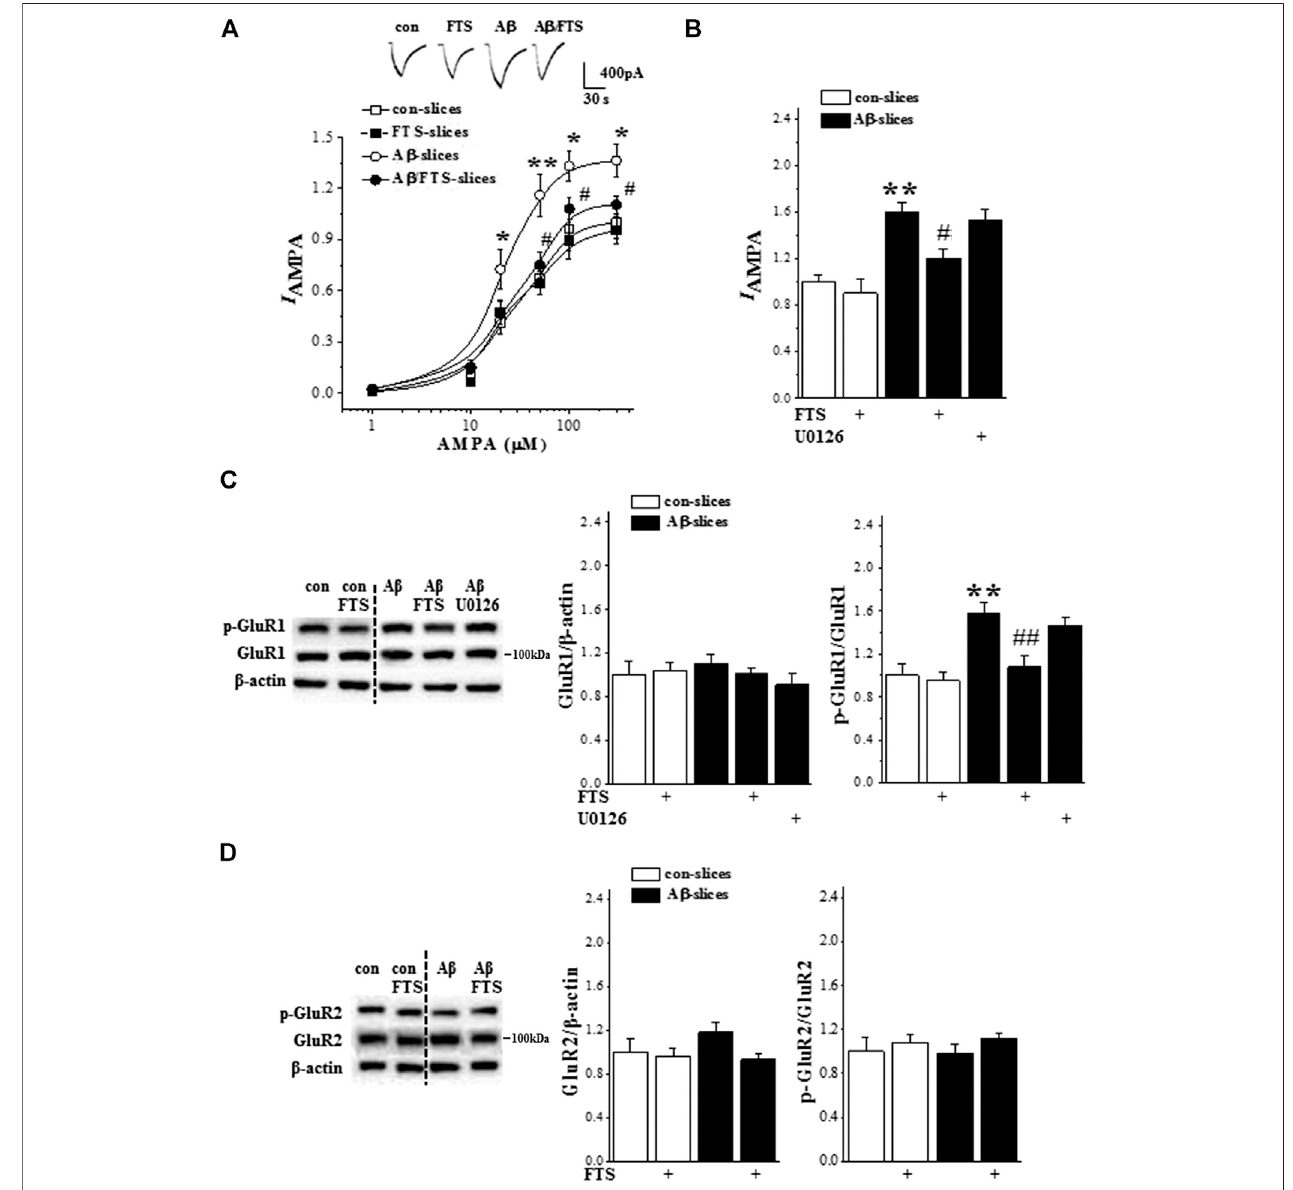
FIGURE5| A β 1-42 -activatedRasenhancesAMPARfunction. (A) Evoked I AMPA byAMPA(1 – 300 μ M)incontrolslices(con),FTS-slices(FTS),A β 1-42 -slices(A β )and A β 1-42 /FTS-slices(A β /FTS).Eachpointrepresentsthedensitiesof I AMPA normalizedbyacontrolvalueevokedbyAMPA(300 μ M).Representativetracesof I AMPA evoked by50 μ MAMPA.* p < 0.05and** p < 0.01vs.controlslices;# p < 0.05vs.A β 1-42 -slices(repeated-measureANOVA,n (cid:1) 6pergroup). (B) Barsshowthedensitiesof I AMPA (50 μ M AMPA) in control slices and A β 1-42 -slice treated with FTS or U0126. ** p < 0.01 vs. control slices; # p < 0.05 vs. A β 1-42 -slices (two-way ANOVA, n (cid:1) 6 per group). (C) and (D) Bargraphsshowthelevelsofphospho-GluR1 andphospho-GluR2normalized bycontrols.** p < 0.01vs. controlslices;## p < 0.01vs.A β 1-42 -slices (two-way ANOVA, n (cid:1) 12 per